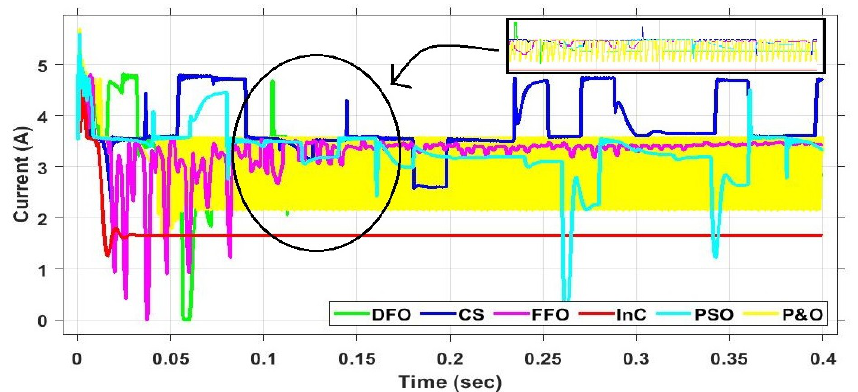
Figure 20. PS3 current comparison between all algorithms for centralized PV system.